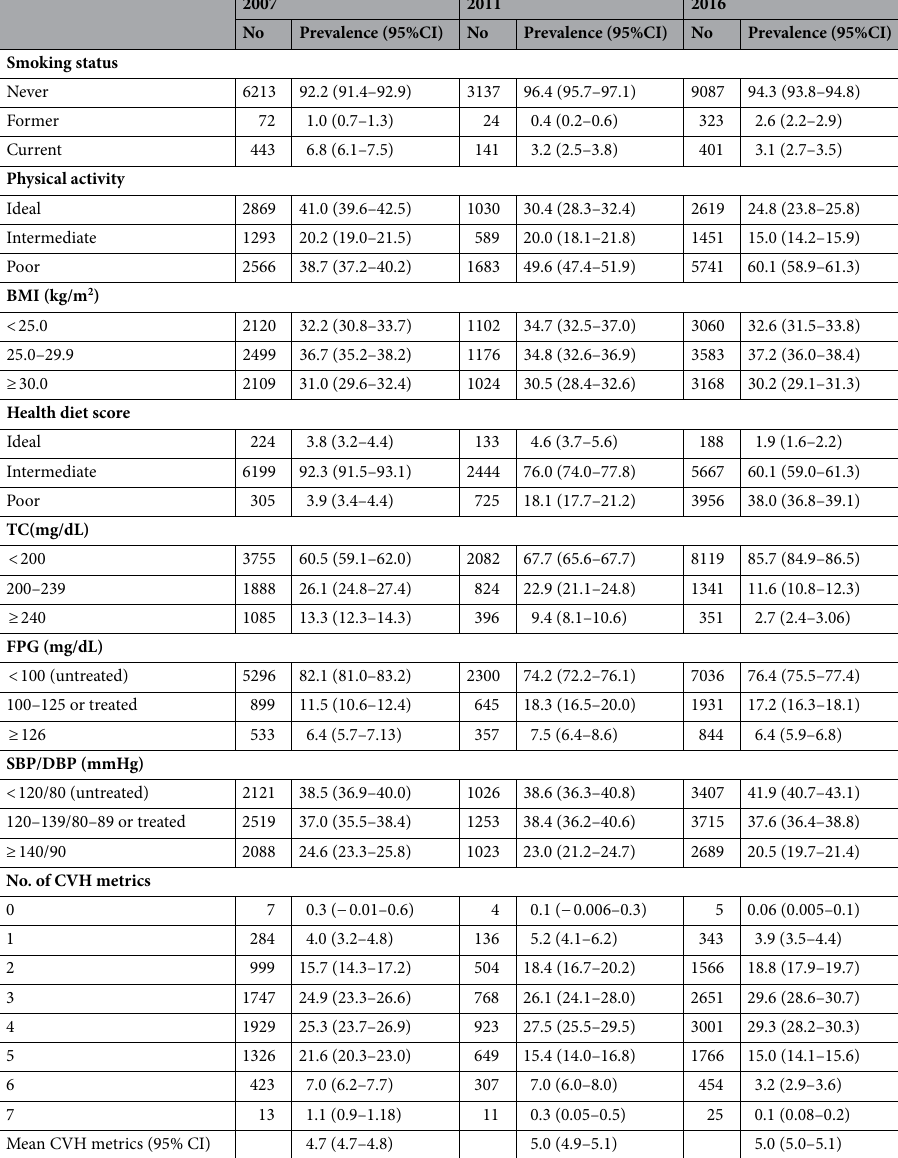
Table 4. Prevalence of cardiovascular health metrics among females in STEPS 2007, 2011, 2016. Data from each survey is weighted for age, sex, area of residence, on the basis of the Iranian census population 2011. STEPS, STEPwise approach to surveillance; CI, confidence interval; BMI, body mass index; TC, total cholesterol; FPG, fasting plasma glucose; SBP, systolic blood pressure; DBP, diastolic blood pressure; ICVH, Ideal cardiovascular health metrics. SI conversion factors: To convert total cholesterol values to mmol/L, multiply by 0.0259; to convert glucose values to mmol/L, multiply by